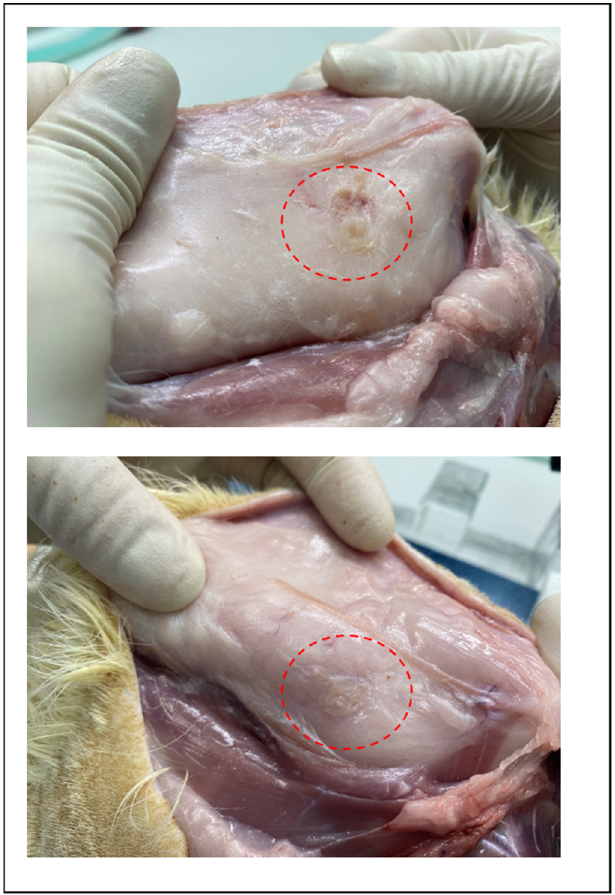
Figure 8. Images of incised back skin of SD rat which is degradation vestige of random PLGA in 6 months after insertion. 6 months after